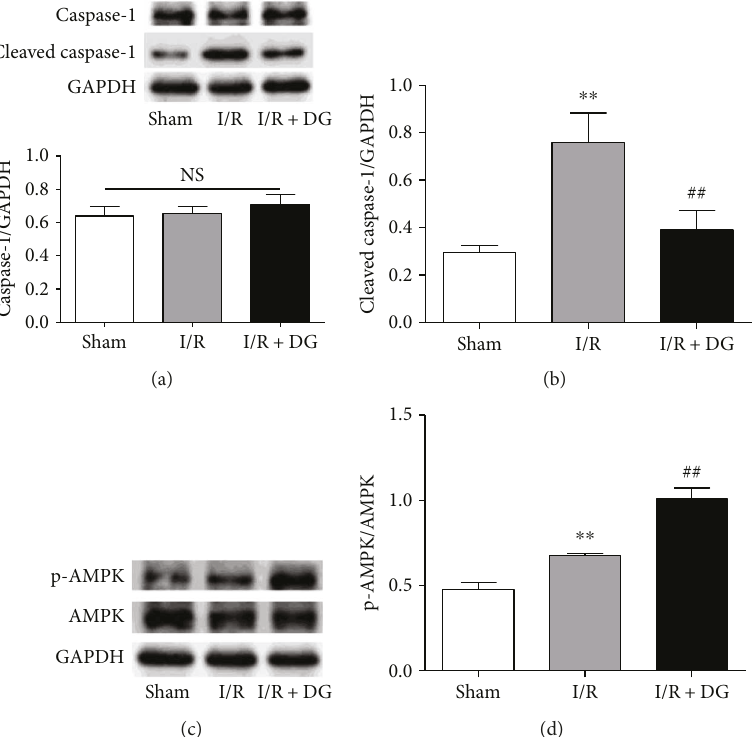
Figure 6: DunyeGuanxinninginhibitedcleaved-caspase-1activitybypromotingAMPKphosphorylation.(a – b)Immunoblotlevelsofcaspase- 1andcleaved-caspase-1intheleftventriculartissue(each n = 4 );(c – d)immunoblotlevelofAMPKphosphorylationintheleftventriculartissue (each n = 4 ). Data are expressed as mean ± SD. ∗∗ P < 0 01 versus sham operation group; ## P < 0 01 versus ischemia-reperfusion